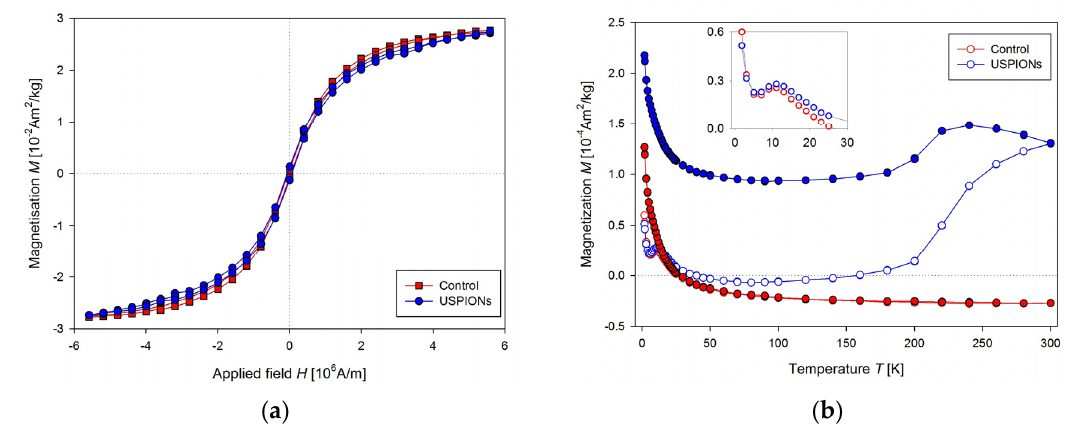
Figure 10. Magnetic properties of the liver of control and USPION-treated rats. ( a ) The mass magnetisation vs. applied magnetic field measurement at a temperature of 2 K, ( b ) the mass magnetisation vs. the temperature at the applied magnetic field of 4000 A/m. The inset shows the peak at the ZFC (zero field cooled) curve both for control and USPIONs group. Curves are the average of 5 measurements per group.